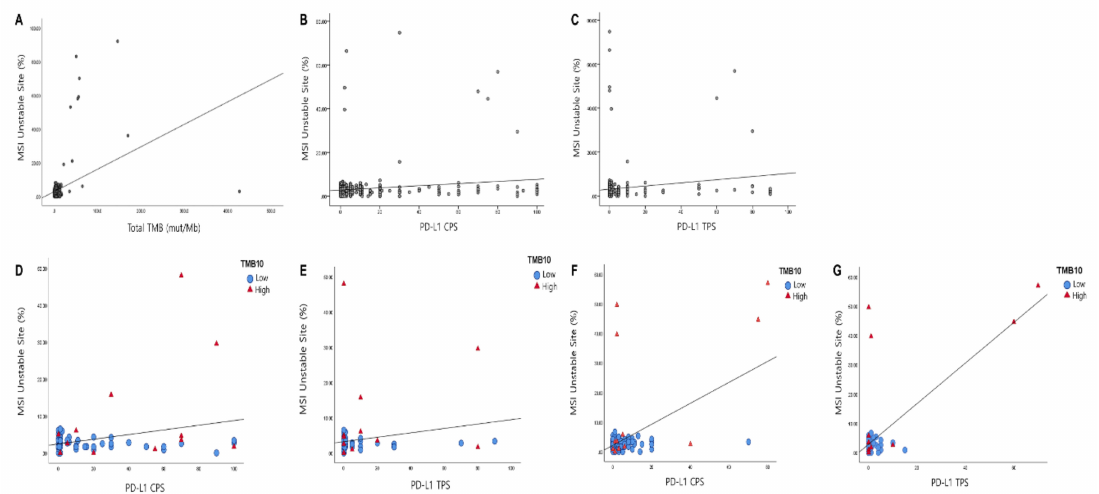
Figure 3. Correlation of microsatellite instability (MSI) site percentage with tumor mutation burden (TMB) and PD-L1 expression. MSI site percentage showed a significant correlation with ( A ) TMB, ( B ) PD-L1 CPS score, and ( C ) PD-L1 TPS score in 588 cases. The MSI site percentage was significantly correlated with the PD-L1 CPS ( D ) ( p = 0.014, R 2 = 0.081), but not with PD-L1 TPS ( E ) in biliary tract carcinoma ( p = 0.118). In gastric carcinoma, the MSI site percentage was significantly correlated with PD-L1 CPS score ( F ) and PD-L1 TPS score ( G ) ( p < 0.001 and R 2 = 0.291; p < 0.001 and R 2 = 0.506,